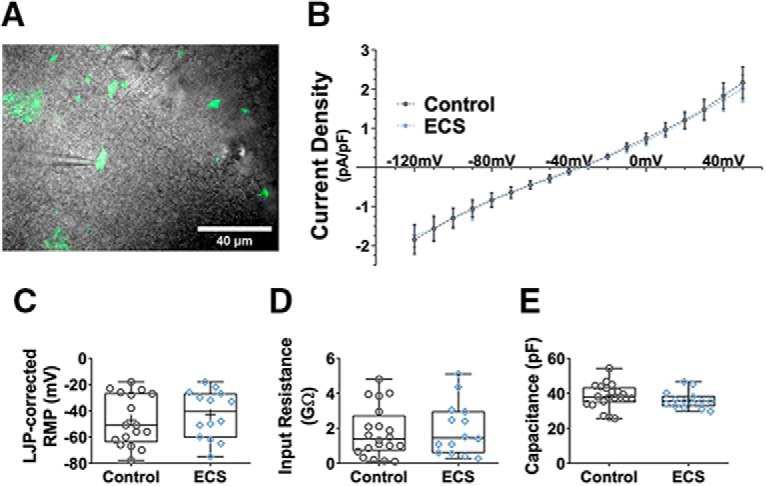
ECS had no effect on intrinsic electrophysiological properties of CA1sr microglia. A, Representative photomicrograph showing GFP-labeled microglia superimposed with a 60× DIC image of the hippocampal slice. B, Current density-voltage relation in microglia was unchanged after ECS. Current amplitudes were measured at steady state during 500-ms voltage steps. Data are shown as mean±SEM. C–E, ECS did not affect microglial RMP (C), IR (D), or membrane capacitance (E).